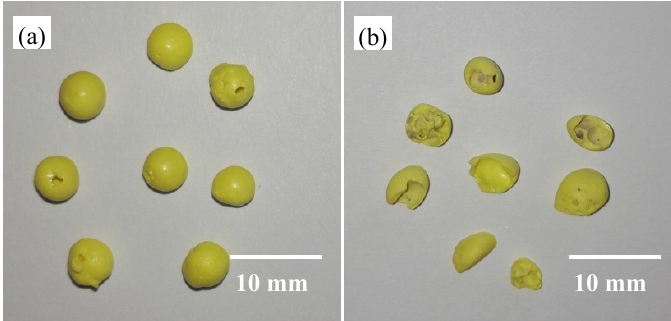
Figure A3. Photographs of sulfur prill-6 before ( a ) and after ( b ) bioleaching.